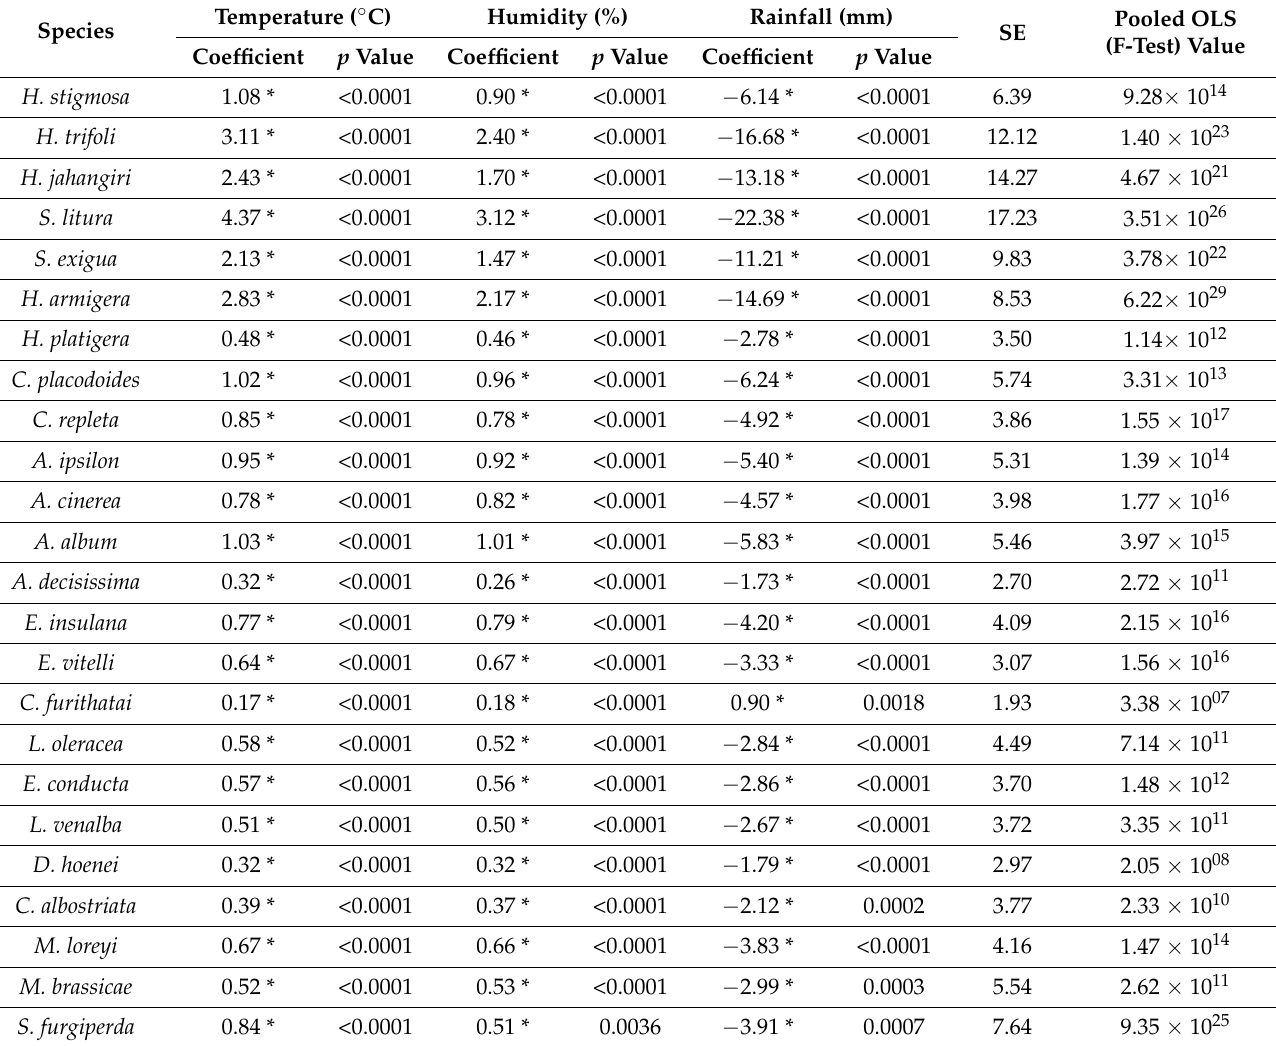
Table 3. The effect of meteorological factors on the species distribution. Fixed effect model (LSDV) for species abundance data. “*” Probability value significant at p < 0.05, SE = Standard error of